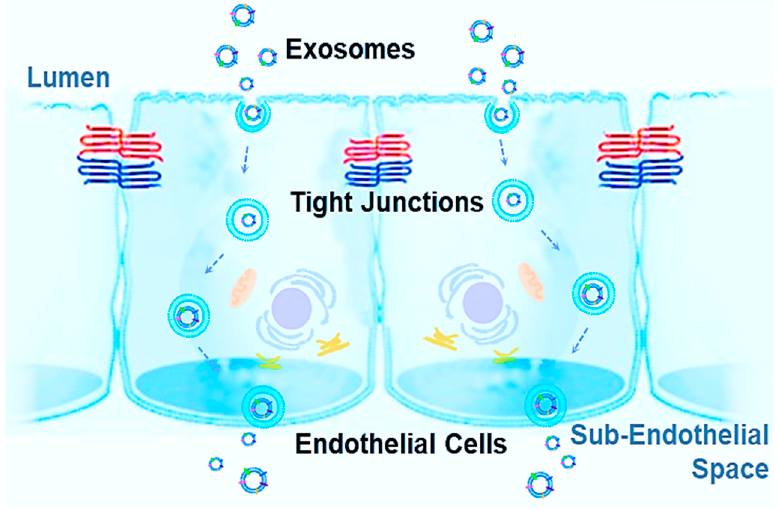
Figure 2. The schematic illustration of exosome transcytosis across biological barriers.